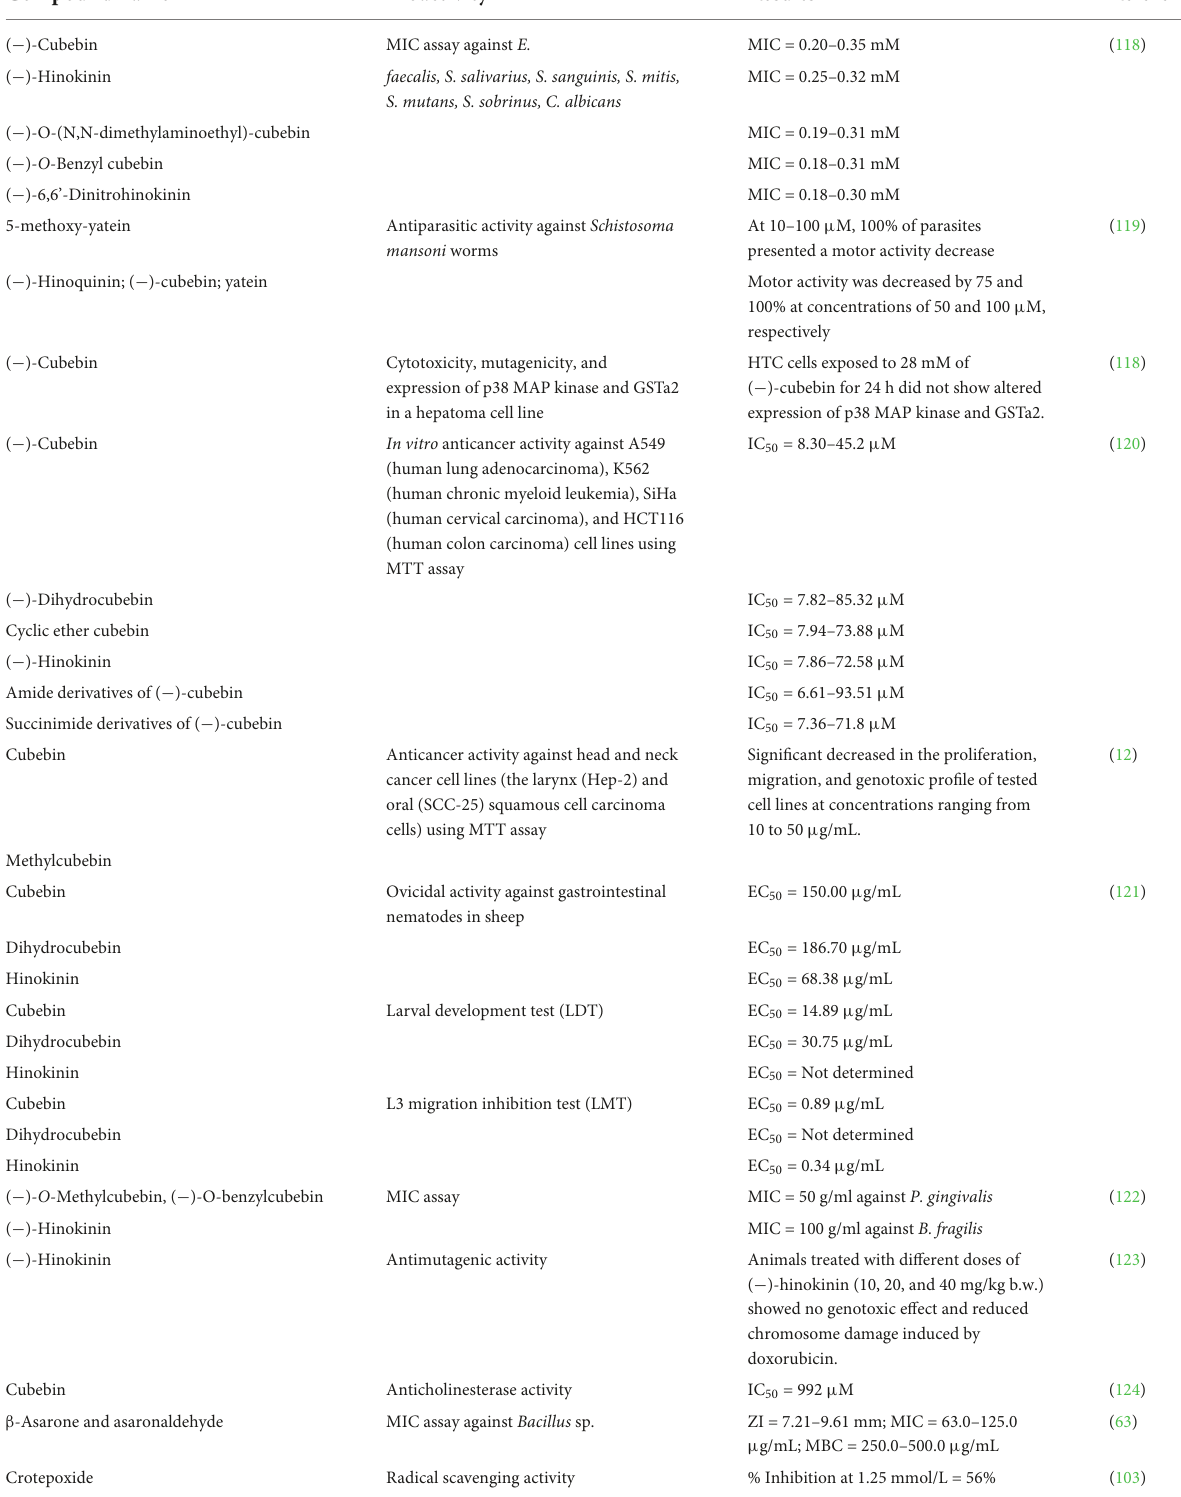
TABLE 7 Biological activities of the isolated compounds from P.